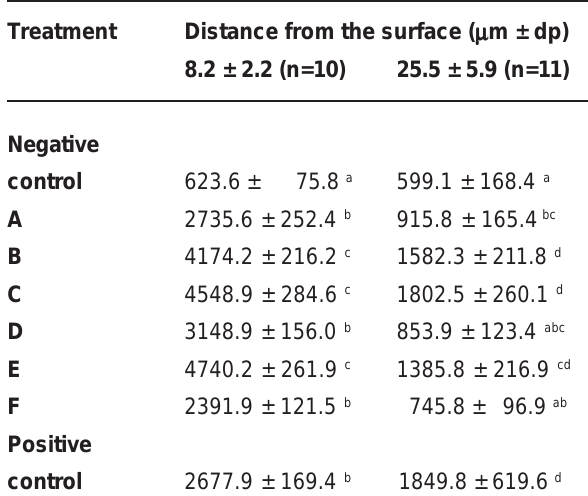
TABLE 2- Concentration (µg/g ± standard error) of fluoride in dental enamel according to the treatments and the removed layer